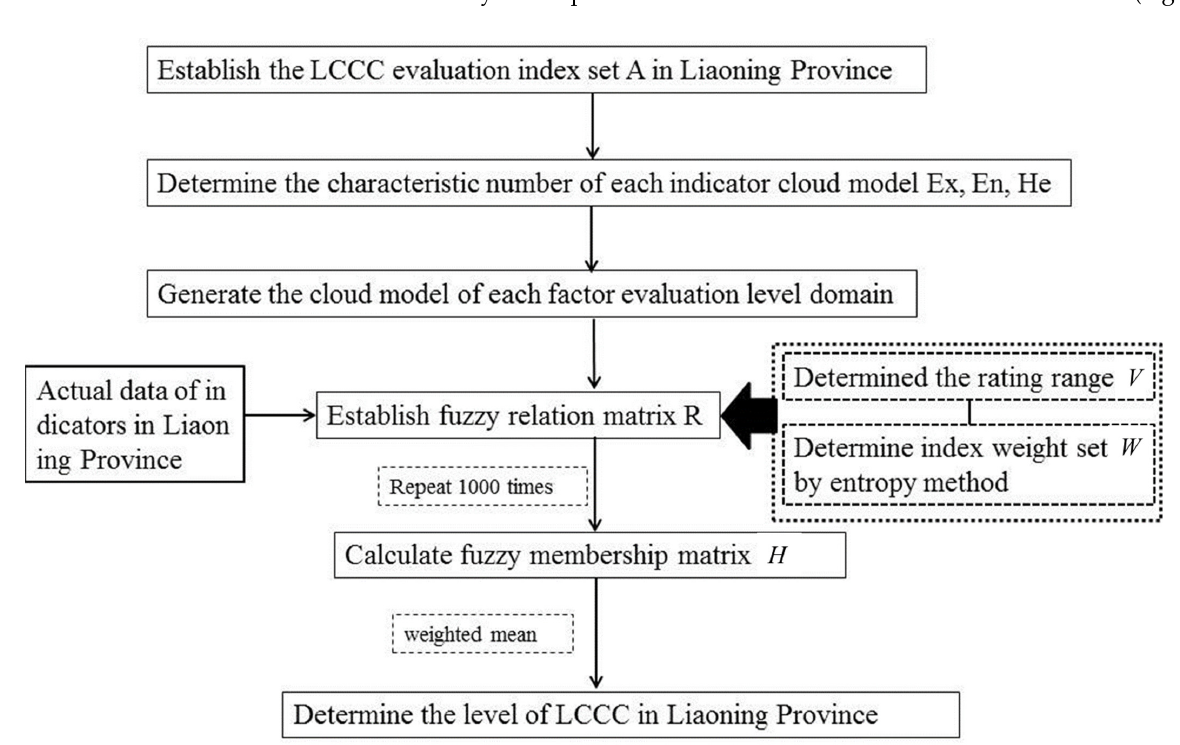
Figure 3. Flow chart of LCCC evaluation method based on normal cloud